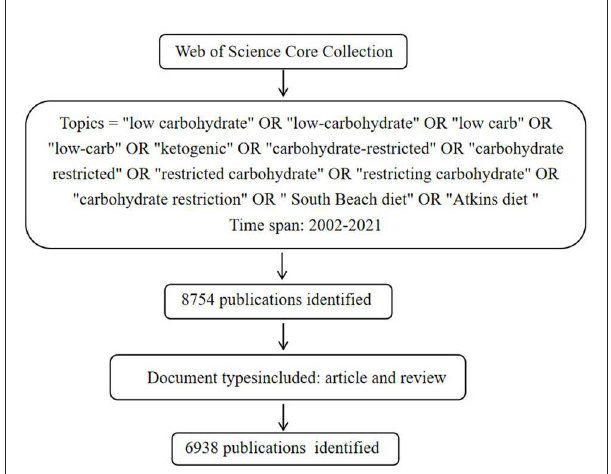
FIGURE1 The flowchart searching papers in databases.